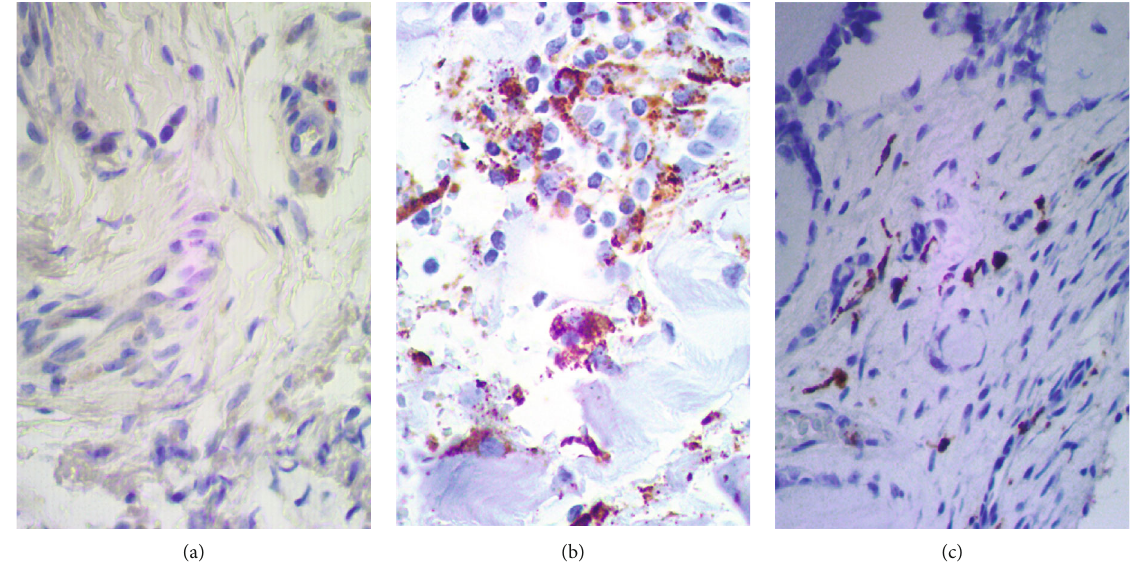
Figure 4: The representative microphotographs showing CD56 and CD68 antigen expression in examined synovial membrane slices. (a) Synovial membrane from hemophilic arthropathy patient ( × 400 magni fi cation) immunostained with anti-CD56 antibody. (b) Synovial membrane from hemophilic arthropathy patient ( × 400 magni fi cation) immunostained with anti-CD68 antibody. (c) Synovial membrane from osteoarthritis patient ( × 400 magni fi cation) immunostained with anti-CD68